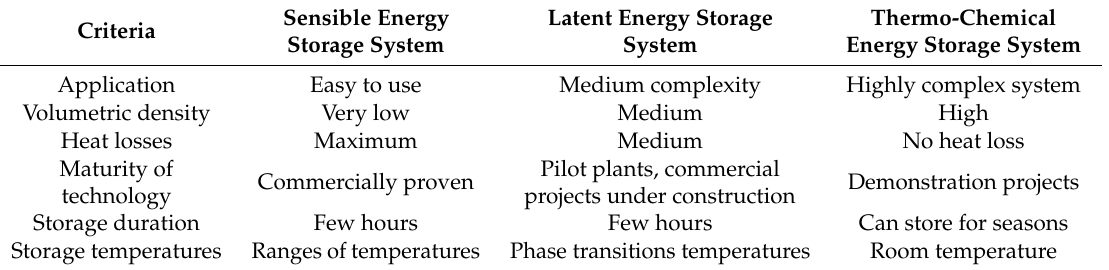
Table 4. Comparison of di ff erent energy storage